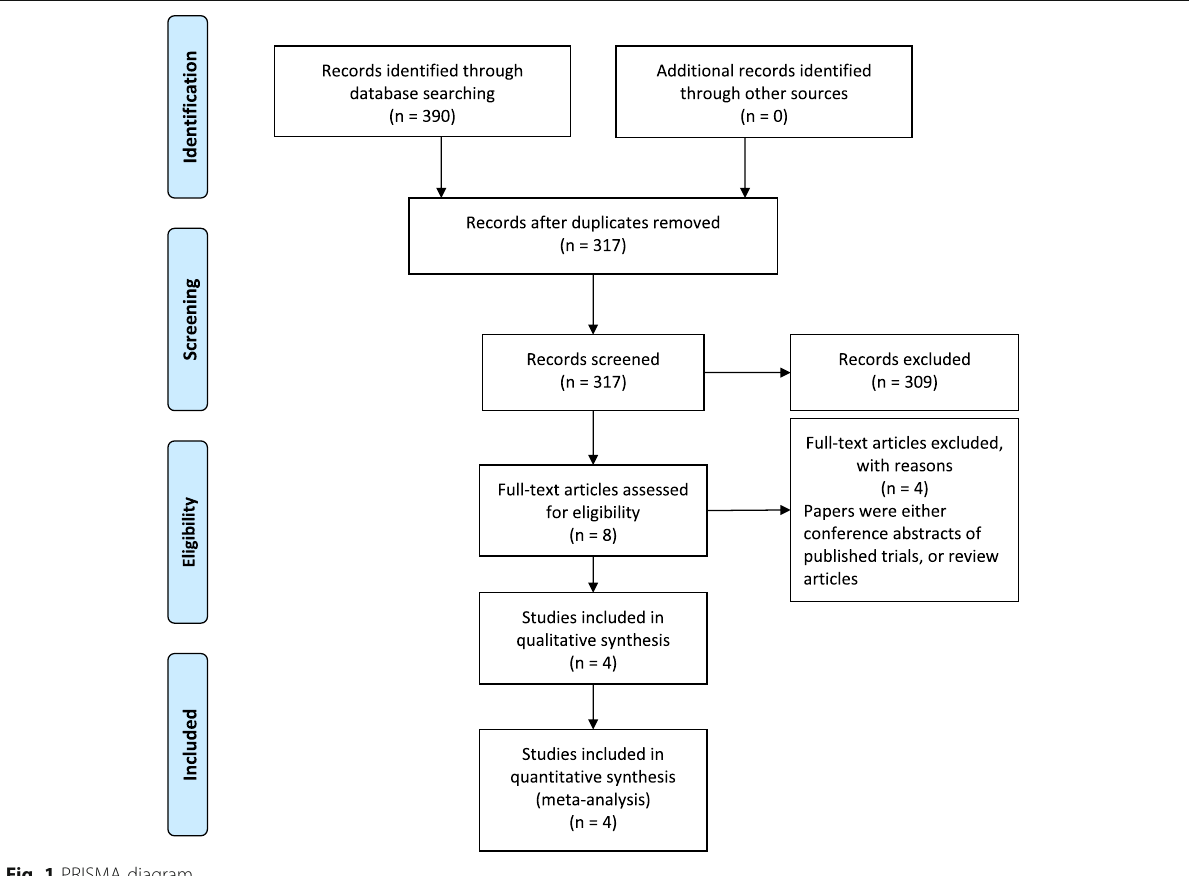
comparing overall adverse effects, no significant differ- ence was found between patients receiving placebo and add-back therapy (LOR = 0.19 CI = − 0.10 to 0.48 I2 = 0.0%, p = 0.194). In contrast patients receiving elagolix experienced a higher incidence of adverse events than both placebo (LOR = 0.84 CI = 0.48 – 1.20 I 2 = 7.8% p = 0.024, I 2 = 64.6%) (Fig. 6). Further analysis revealed that hot flashes, nausea, and headaches were the only re- ported adverse effects that varied in incidence based on the treatment (Fig. 7, Supplemental Figures 1-3). Hot flashes were reportedly higher in the elagolix only treat- ment group compared to both placebo (LOR = 2.81, CI (LOR = 1.66, CI = 1.29 – 2.03, p = 0.0, I 2 = 22.8%). On the other hand, nausea was significantly higher in the add back group compared to the elagolix only group (LOR = 0.77 CI = 0.30 – 1.24, p = 0.001, I 2 = 0.0%). Fur- thermore, the incidence of headaches was significantly lower in the placebo group when compared to both the interventions (E vs PBO: LOR = 0.75, CI = 0.28 – 1.21, p 0.94, p = 0.042, I2 =